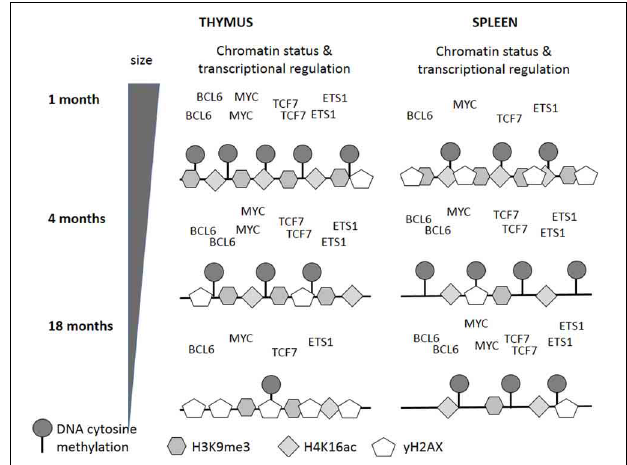
FIGURE 9 | Changes in epigenetic and transcriptional regulation may underlie age-related changes in genome stability and organ function. The black lines indicate DNA, the numbers of symbols correlate with the experimental data and are relative to the presence of the corresponding marks in young animals. Transcription factor names occur relative to expression levels and are also relative to the expression in young